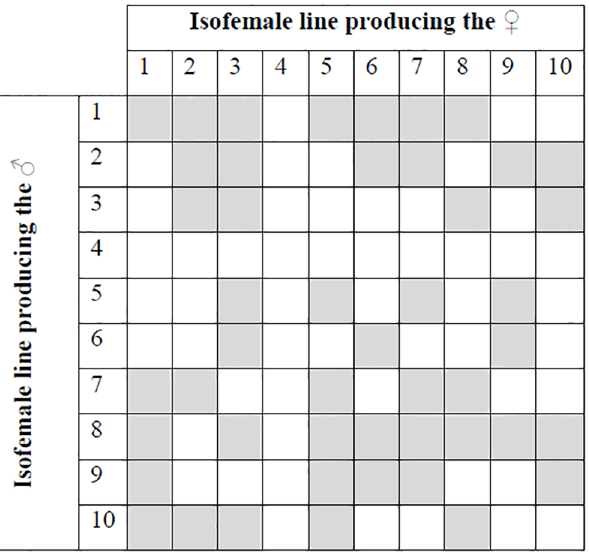
Fig 1. Isofemale line combinations that were assayed. Combinations that were mated in singly-mated crosses are shaded (see Methods). All combinations (shaded and unshaded) were used in the multiply- mated